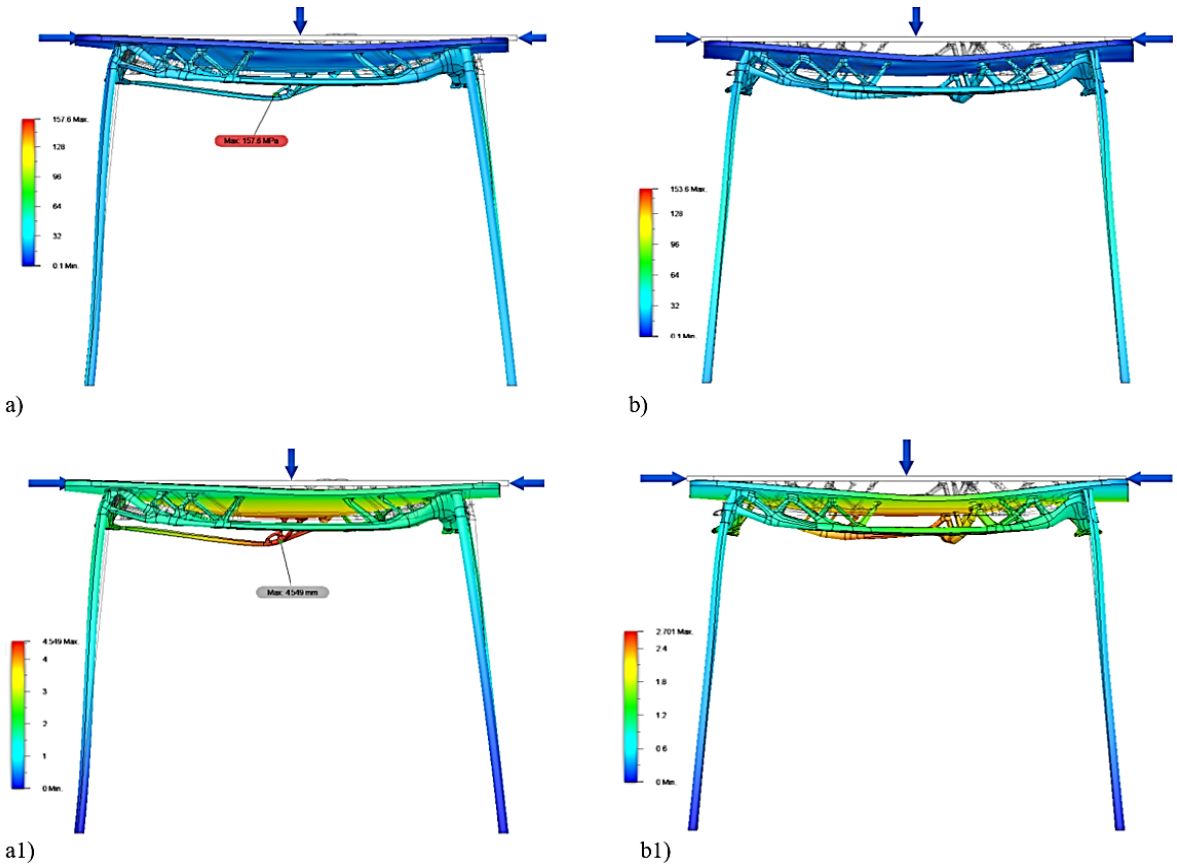
Figure 14. After redesign process models have a better behavior in FE analysis. a) The maximum Von Misses stress in model_1 is lower than the initial model, especially in legs the stress is up to 70 MPa; a1) The total displacement of model_1; b) The maximum Von Misses stress in model_2 reduced about 80 MPa; b1) The total displacement of model_2.